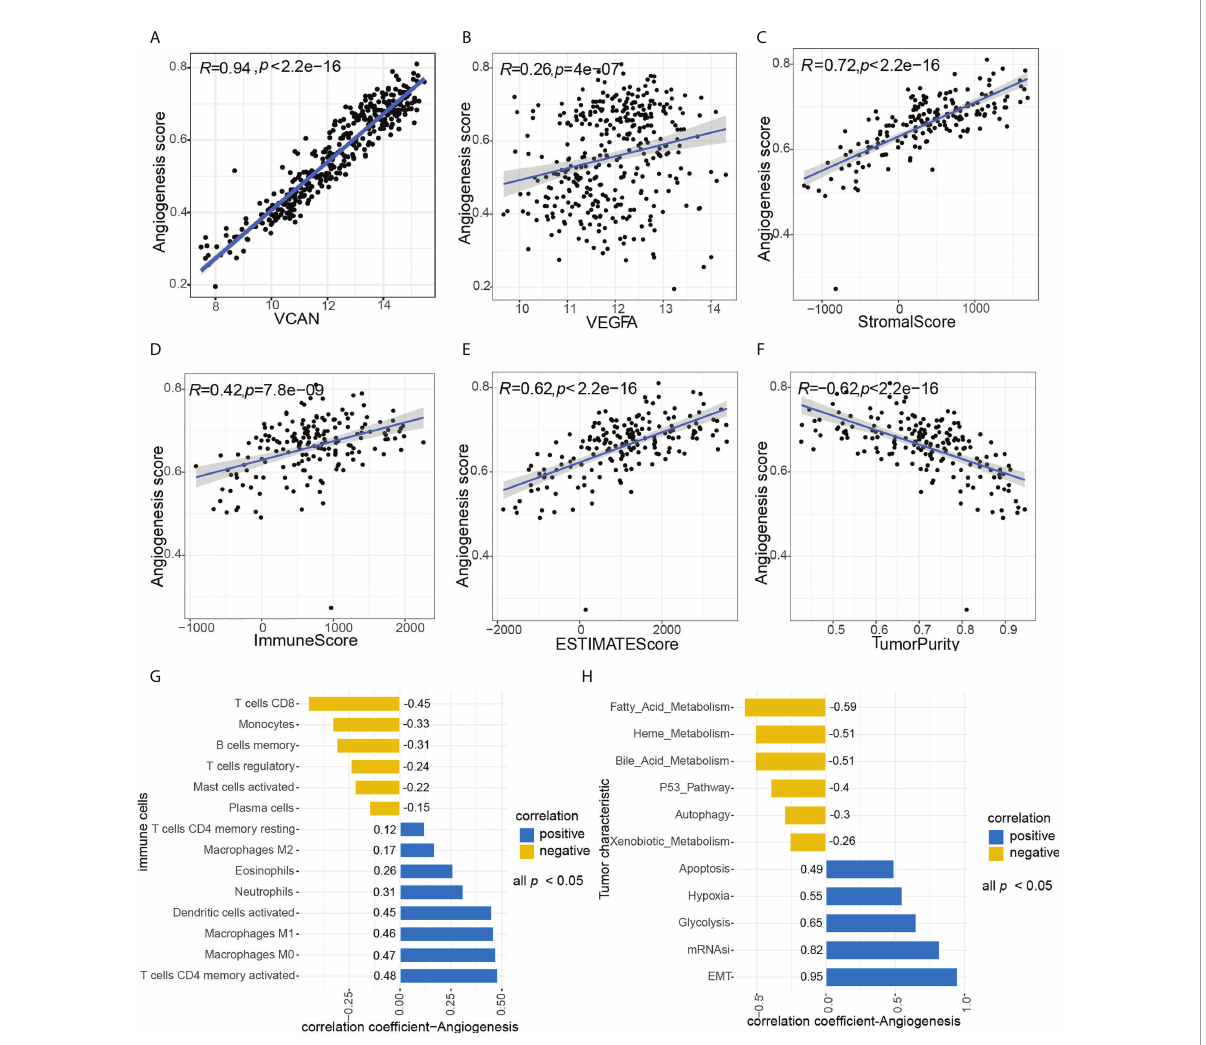
FIGURE 2 Association between angiogenesis with tumor characteristics. (A , B) Association between angiogenesis score and representative angiogenesis genes, A (VCAN), B(VEGFA). (C – F) Correlation of angiogenesis score with TME and tumor purity, C (StromalScore), D (ImmuneScore), E (ESTIMATEScore), F (TumorPurity). (H) Association between angiogenesis score and immune cells, all p value < 0.05. (G) Association between angiogenesis score and tumor characteristics, all p value <